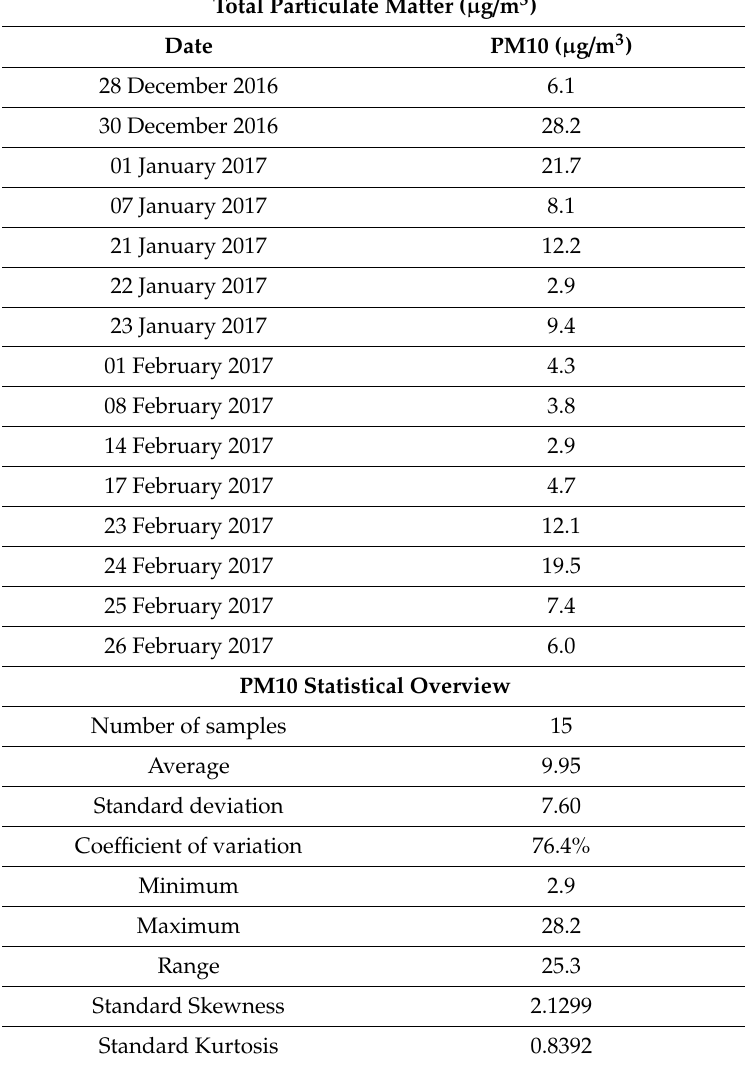
Table 1. Particulate matter (PM) statistical summary together with central tendency, variability, and distribution